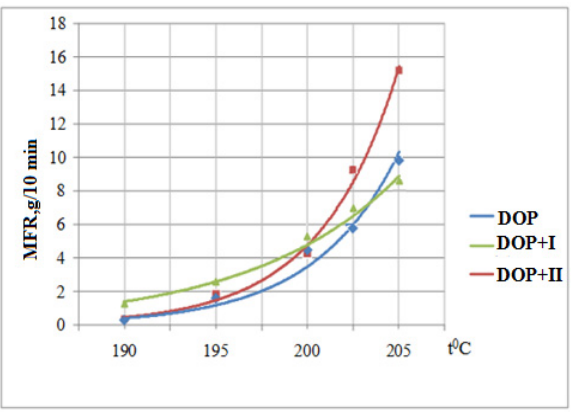
Figure 10. Dependence of the MFR of PVC composition on temperature. I–II—Symbols of plasticizers (Table